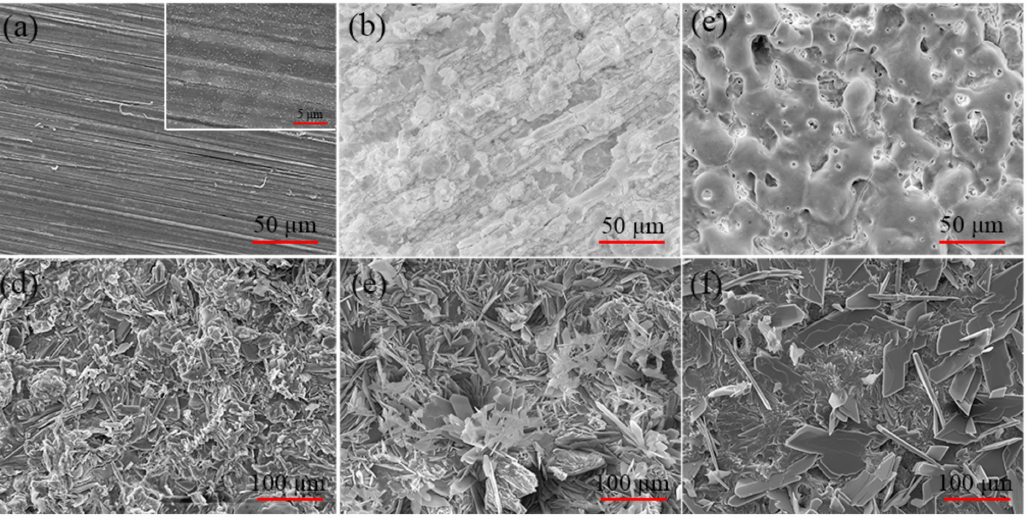
Figure 2. Morphologies of the pre-treated and CaPh-coated substrates: ( a ) HT sample; ( b ) AT sample; ( c ) PEO sample; ( d ) HT-C sample; ( e ) AT-C sample; ( f ) PEO-C